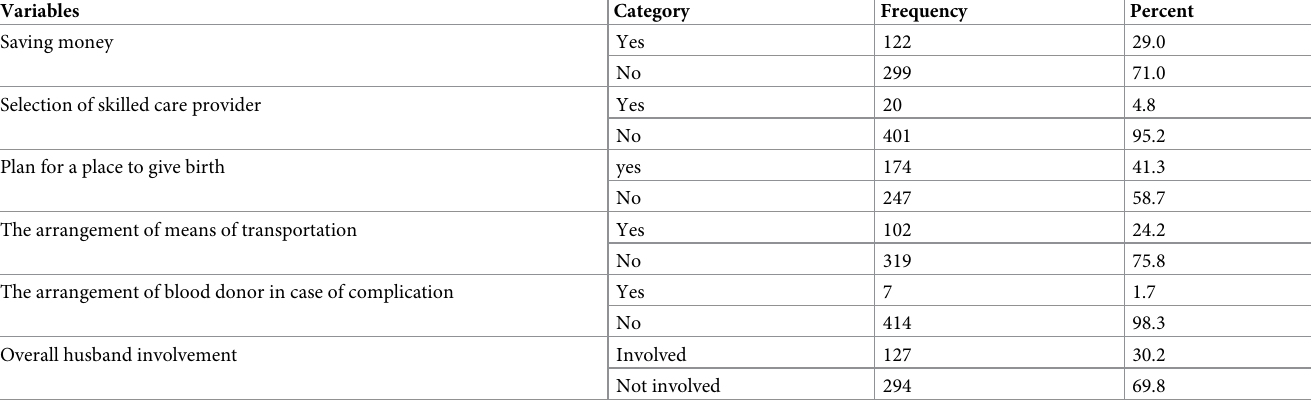
Table 4. Components of birth preparedness and complication readiness in Kucha district, Gamo zone, Southern Ethiopia, 2018.